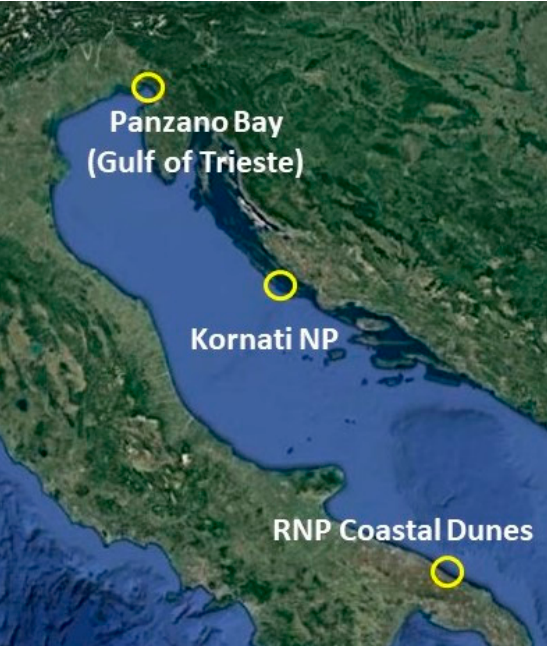
Figure 2. The sites where SASPAS partners performed transplantation tests, as part of the project concrete actions: Panzano Bay, in Monfalcone, nearby Trieste; Kornati National Park, in Dalmatia; Regional Natural Park of Coastal Dunes, nearby Brindisi.